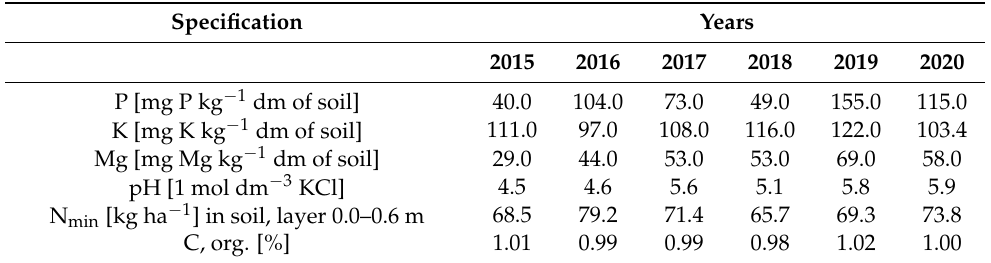
Table 1. Nutrient contents and soil pH before establishing the experiment in maize growing seasons. Specification